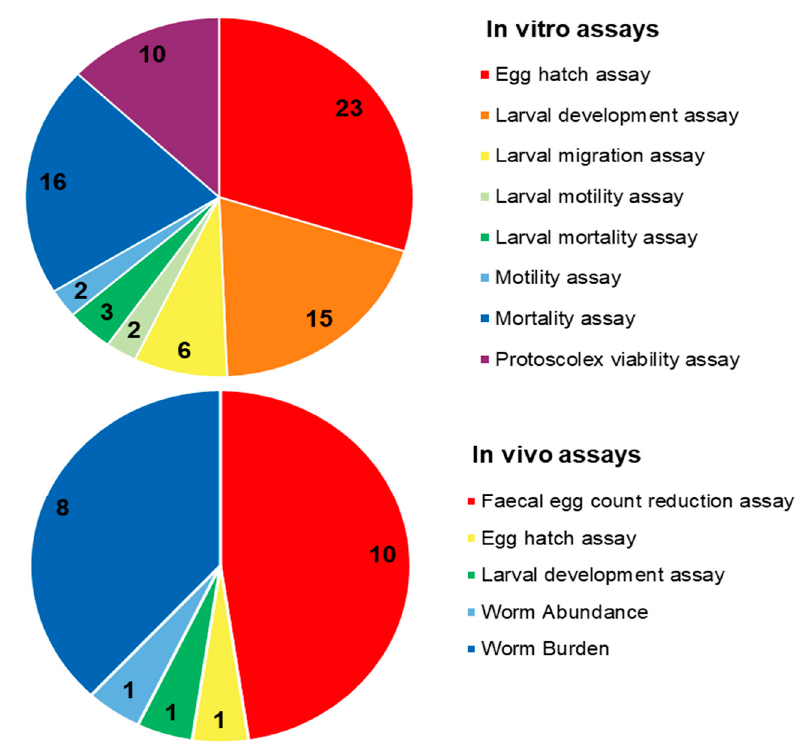
Figure 4. Distribution of different anthelminthic assay methods in in vitro and in vivo experi ‐ ments.